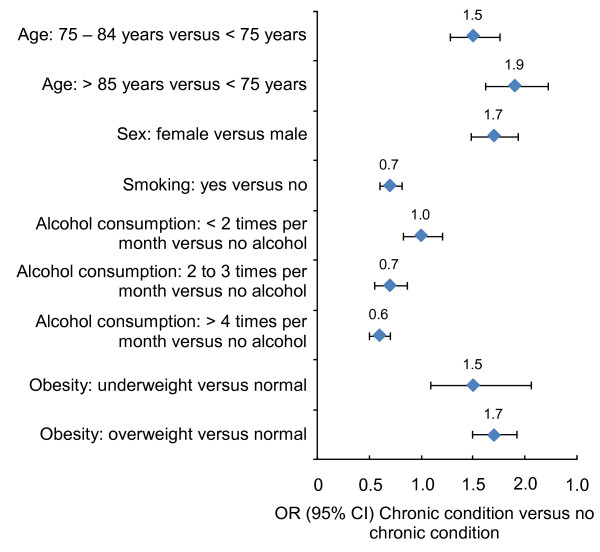
Odds ratios for covariates. Notes: N = 19,953.